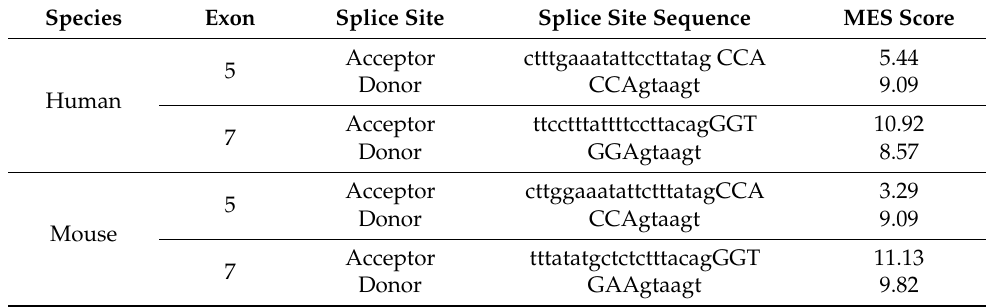
Table 3. Predicted splice site scores of human SMN1 and mouse Smn exons 5 and 7 using Max- EntScan. Nucleotides in CAPITALS indicate exon sequence, lower case nucleotides represent intronic